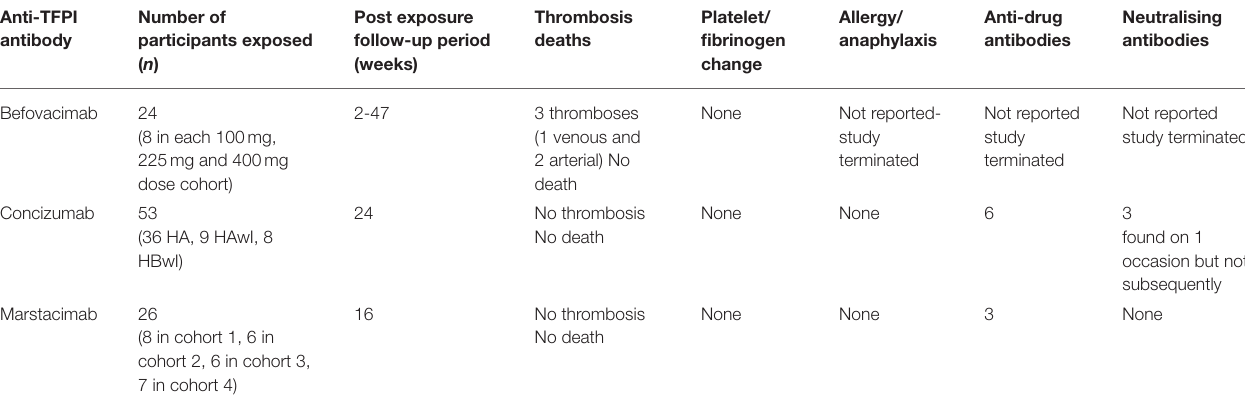
TABLE 2 | Adverse events of special interest in phase 2 anti-TFPI clinical trials (19, 24, 28). Anti-TFPI